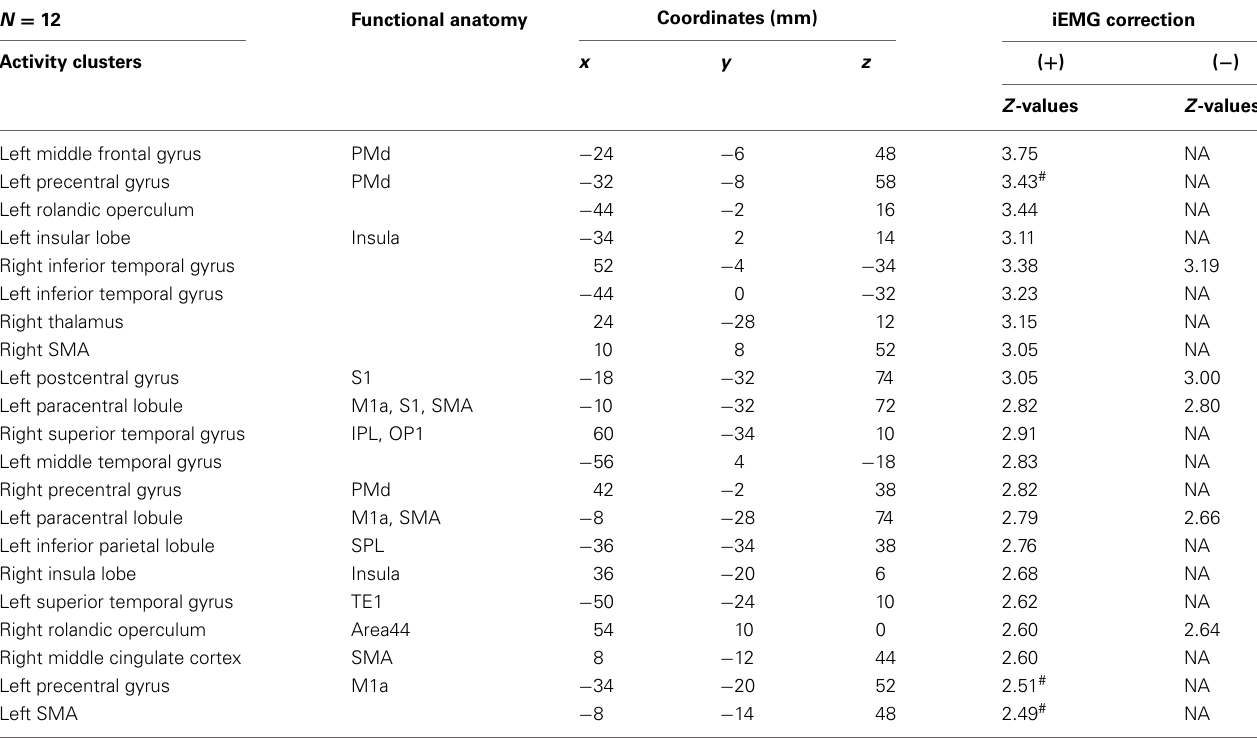
Table 2 | Supra-TMS compared with motor-MNS (Uncorrected P < 0 . 005). N = 12 Functional anatomy iEMG correctionCoordinates (mm) Activity clusters